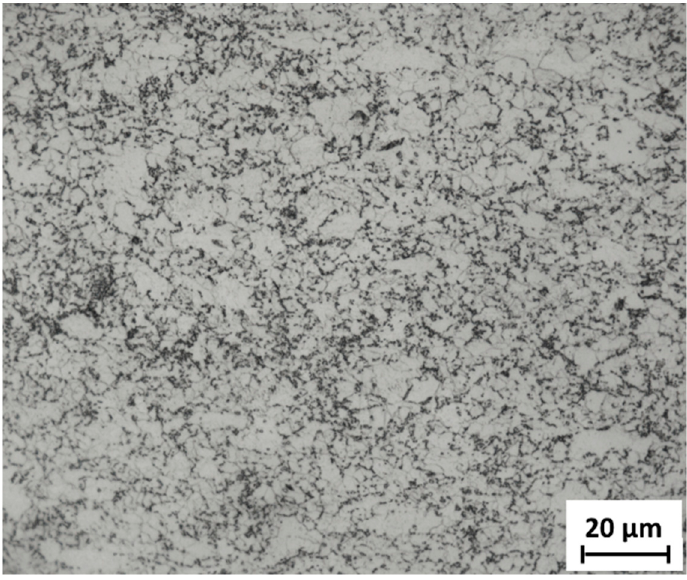
Figure 4. The microstructure of 22MnB5 consisting of ferrite and spheroidized